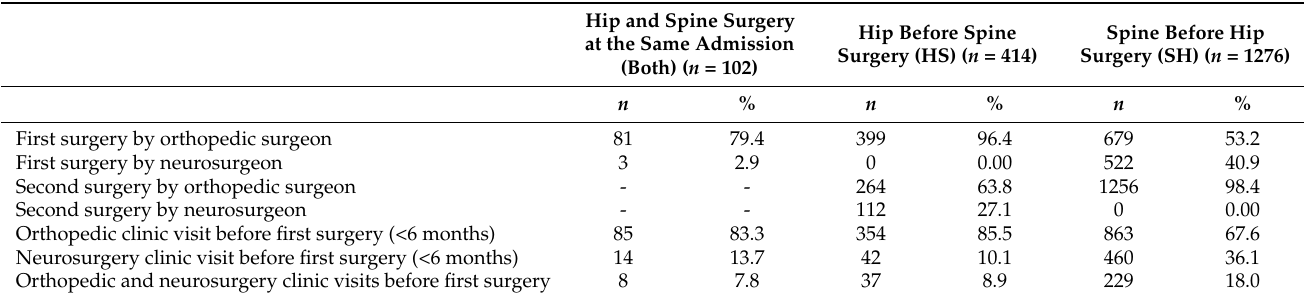
Table 3. Comparison of preoperatively arranged imaging studies in each group.